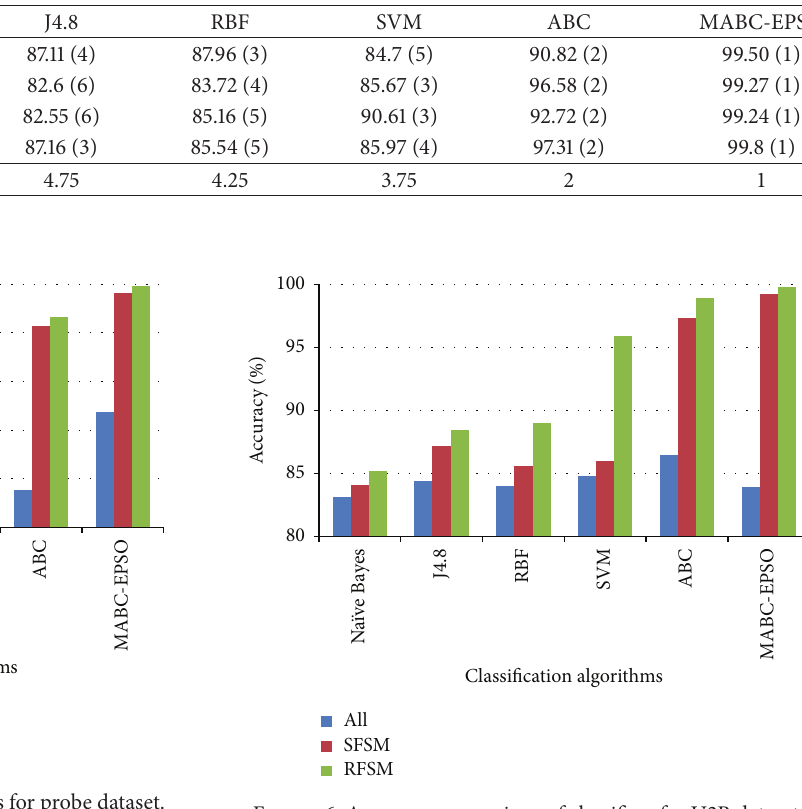
is also observed that on applying random feature selection method, the accuracy of SVM and ABC is increased to 95.71% and 97.92%. The accuracy rate of NB, j4.8, and RBF classifiers is comparatively high with RFSM method compared to SFSM and full feature set.